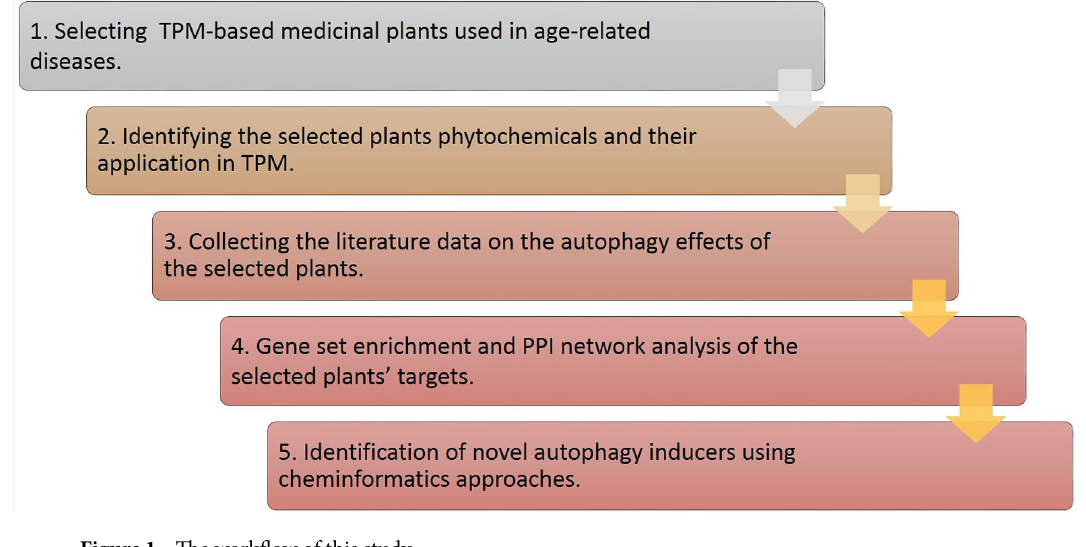
Figure 1. The workflow of this